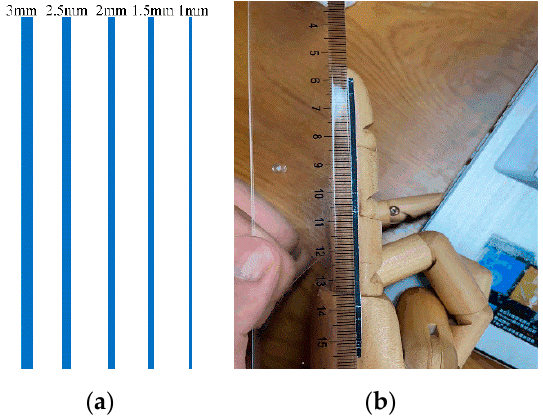
Figure 4. Finger-joint markers and their method of attachment.